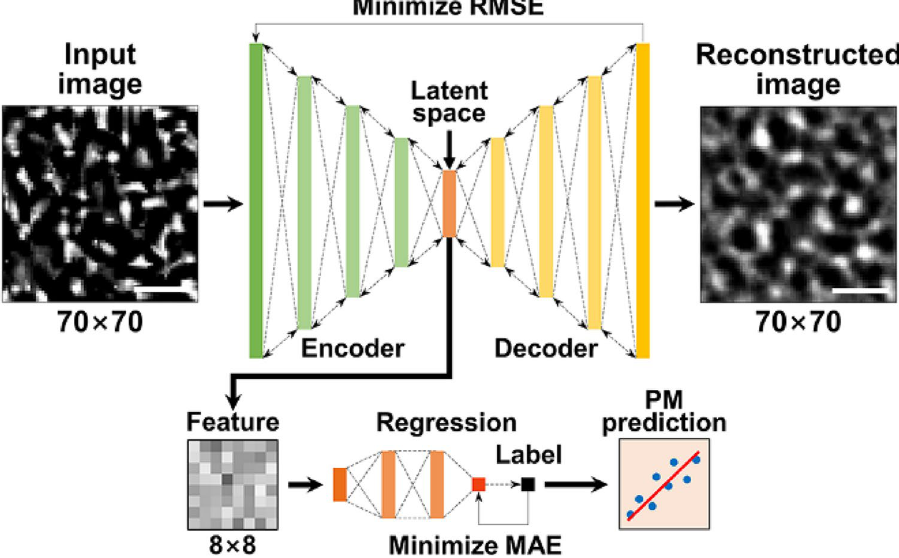
Figure 3. Architecture of the deep learning algorithms used for feature extraction and regression analysis. Scale bars are 5